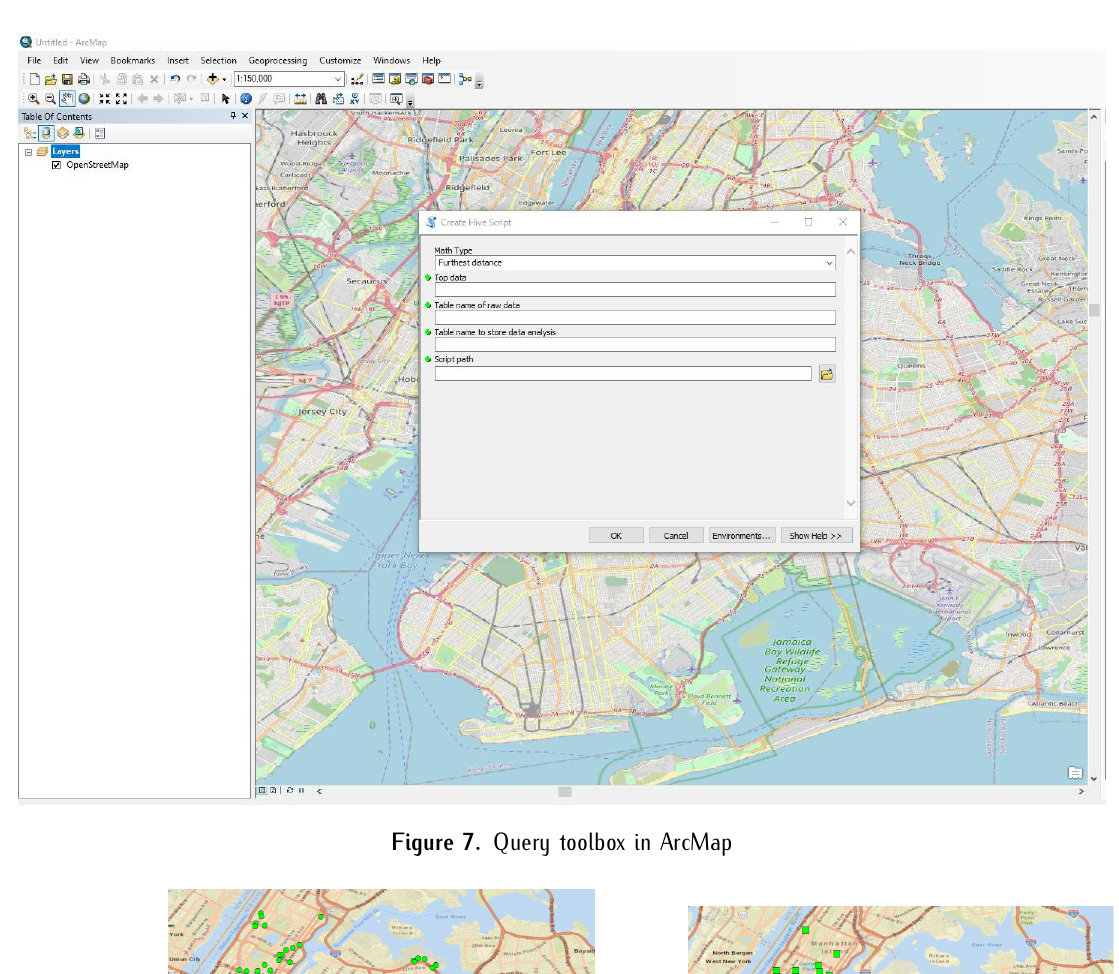
Figure 7. Query toolbox in ArcMap